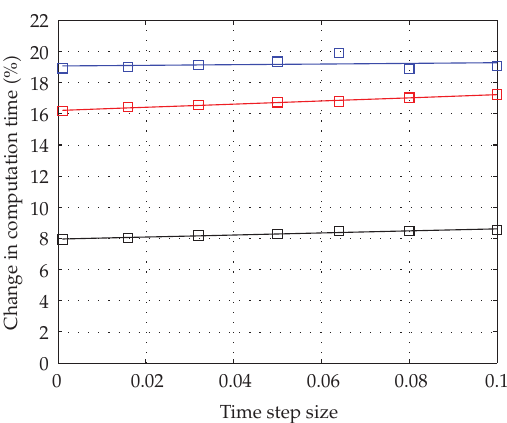
Figure 14: Relative change in computation time of the TSRK4 method compared with the ARK4 method in solving IVP-1 (cid:4) blue (cid:5) , IVP-2 (cid:4) red (cid:5) , and IVP-4 (cid:4) black (cid:5) , showing that TSRK4 requires greater computation